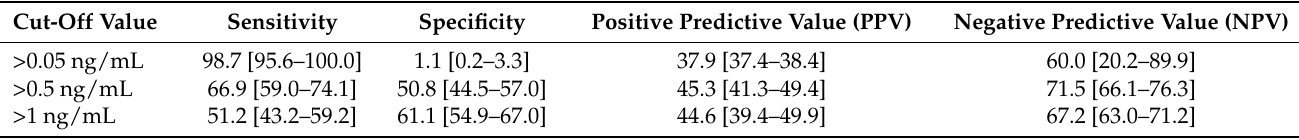
Table 6. Sensitivity and specificity for different cut-off values of PCT at emergency department admission for suspected sepsis in ED (Sep group), for all-cause in-hospital death. Overall ROC AUC was 0.580 [0.532–0.628). The best discriminating value according to Youden index J was PCT > 0.33